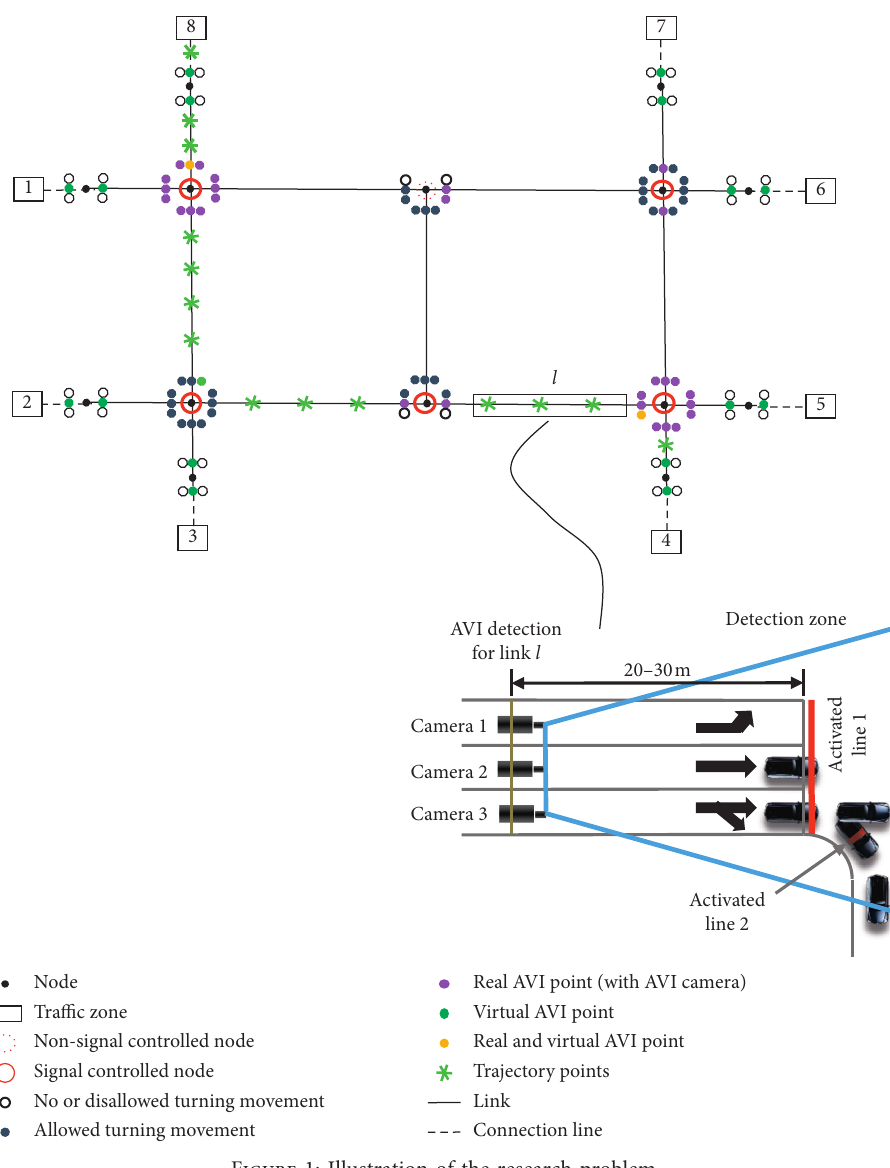
Figure 1: Illustration of the research